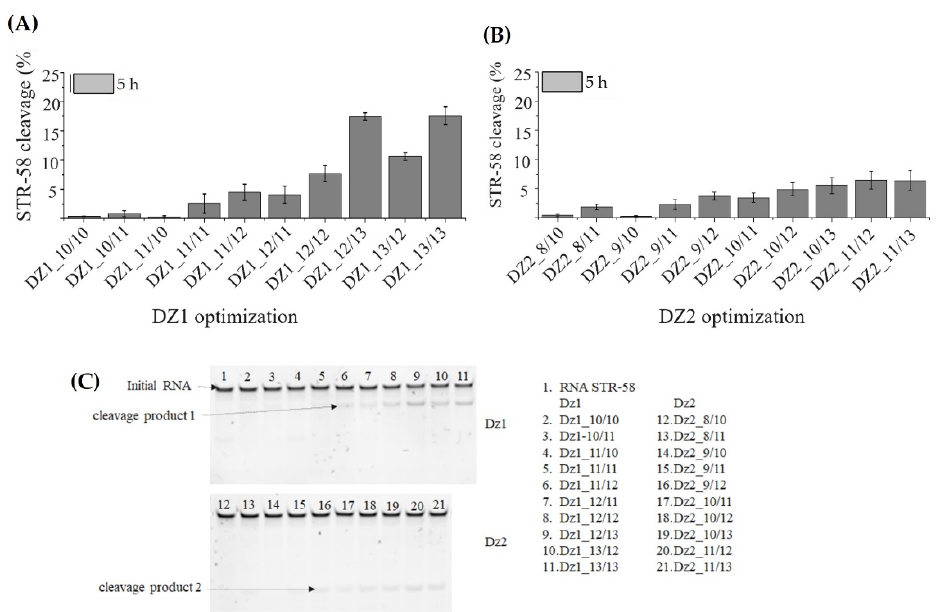
Figure 6. Optimization of Dz1 and Dz2 with varied binding arms and melting temperatures. ( A ) Dz1 optimization with varying binding arm lengths ranging from 10 to 13 nucleotides aimed at STR-58. ( B ) Dz2 optimization with a varied binding arm length of 8 to 13 nucleotides. ( C ) Optimization of Dz1 and Dz2 by PAGE electrophoresis.